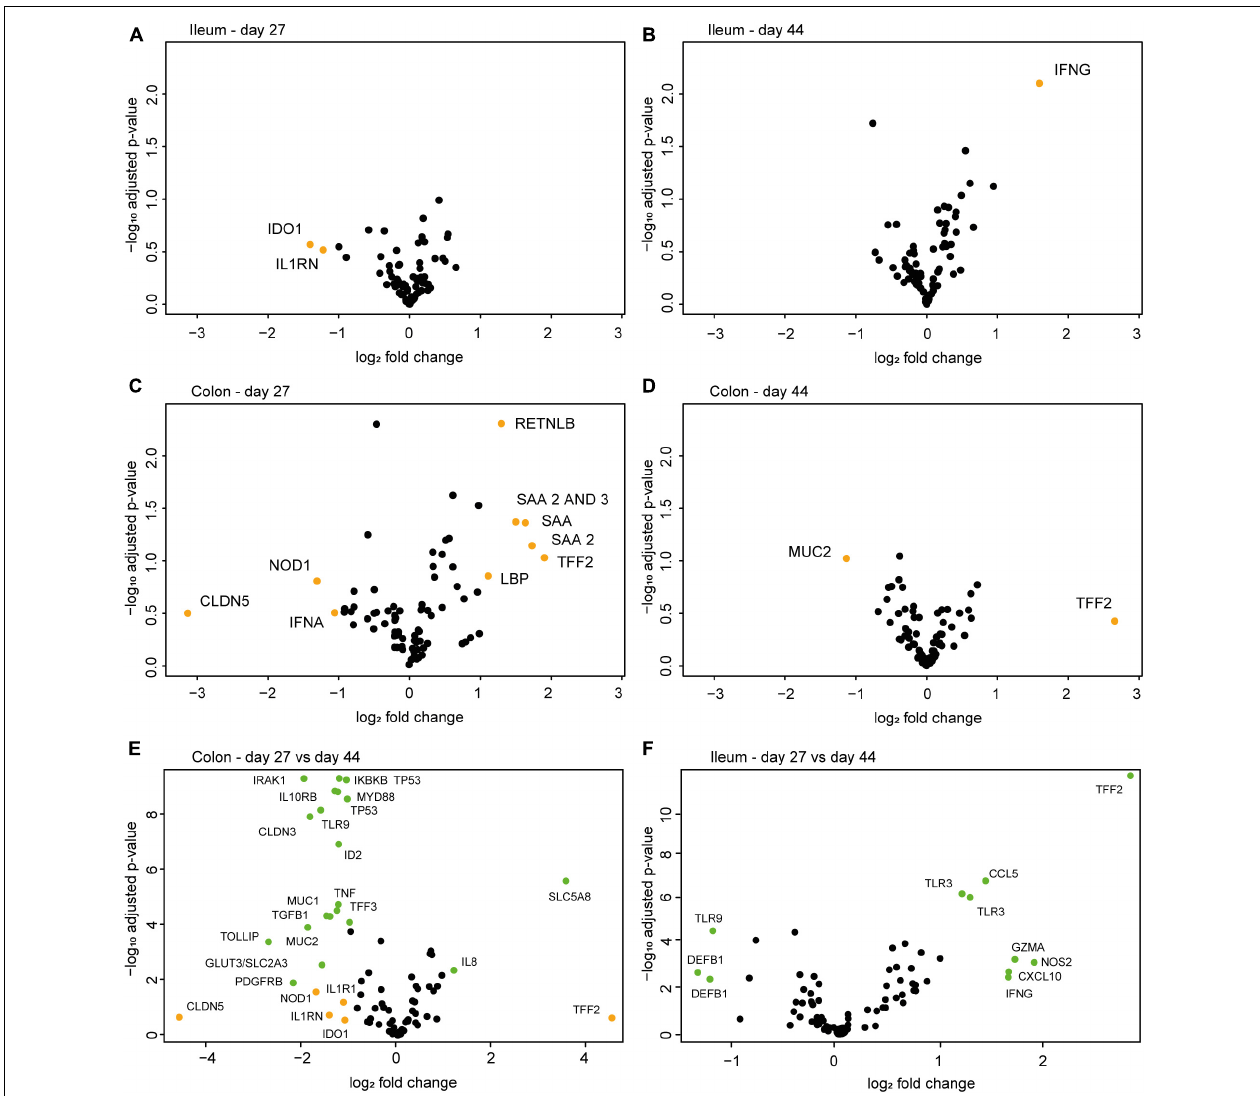
FIGURE 5 | Volcano plots of differentially expressed genes between the control group and the EcN group ( n = 8 per group) in mucosal scrapings of the ileum (A,B) and colon (C,D) on day 27 (pre-weaning) and day 44 (post-weaning) of the study. No significantly differentially expressed genes were observed between the treatment groups in any gut segment or time point. Fold change on the x -axis depicts the fold-change difference in the EcN treatment group compared to the control group. When comparing all samples from the colon (E) or ileum (F) from day 27 with those of day 44 (both treatment groups), several differentially expressed genes were identified. Fold change on the x -axis depicts the fold-change difference between time points. Orange points indicate the differentially expressed genes with a fold change > 2. Green points indicate differentially expressed genes with a fold change > 2 and a p -adj. <